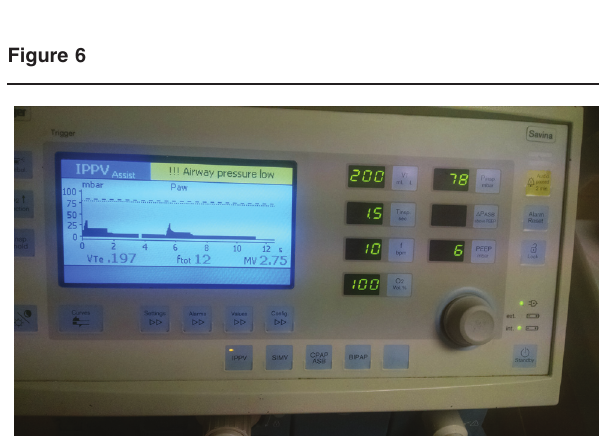
Postbronchoscopic toileting decreased peak pressure in the ventila- tory